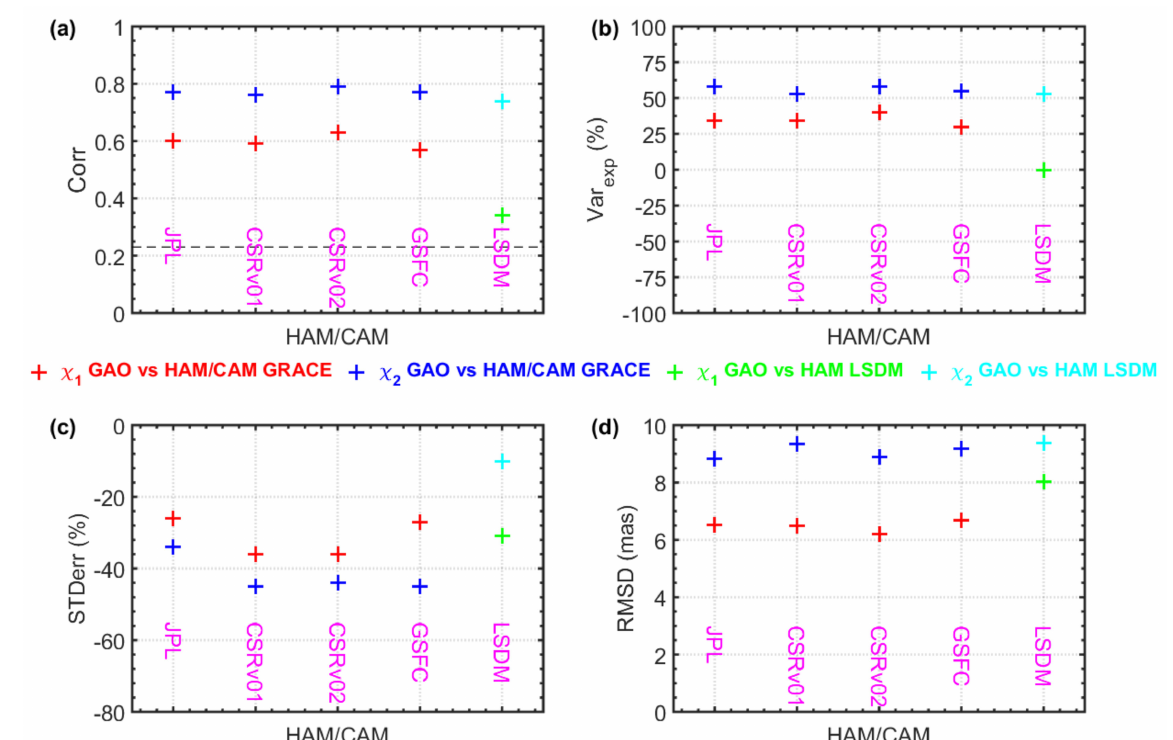
Figure 2. ( a ) Correlation coefficients (Corr) between HAM/CAM and GAO and between HAM and GAO, ( b ) percentage of variance in GAO explained by HAM/CAM and HAM (Var exp ), ( c ) error of standard deviation (STD) (STDerr) of HAM/CAM and HAM, and ( d ) root mean square deviation (RMSD) of HAM/CAM and HAM. The overall detrended time series are considered. Note that the critical value of the correlation coefficient for the overall time series for 53 independent points and a 95% confidence level is 0.23 (shown as a black dashed line), while the standard error of the difference between the two correlation coefficients is